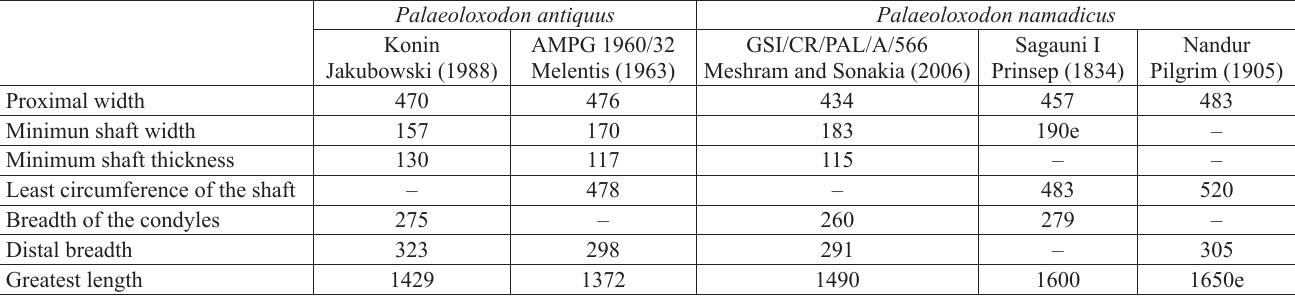
Table 9. Measurements (in mm) of femora of different Palaeoloxodon specimens; e,